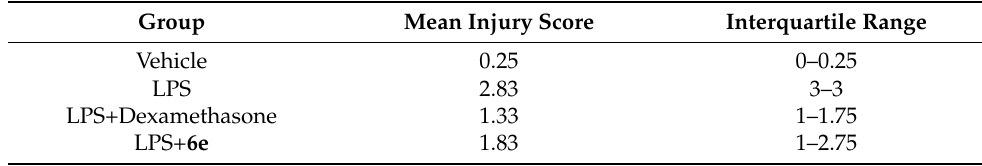
Table 2. Semi-quantitative morphological score of lung tissue